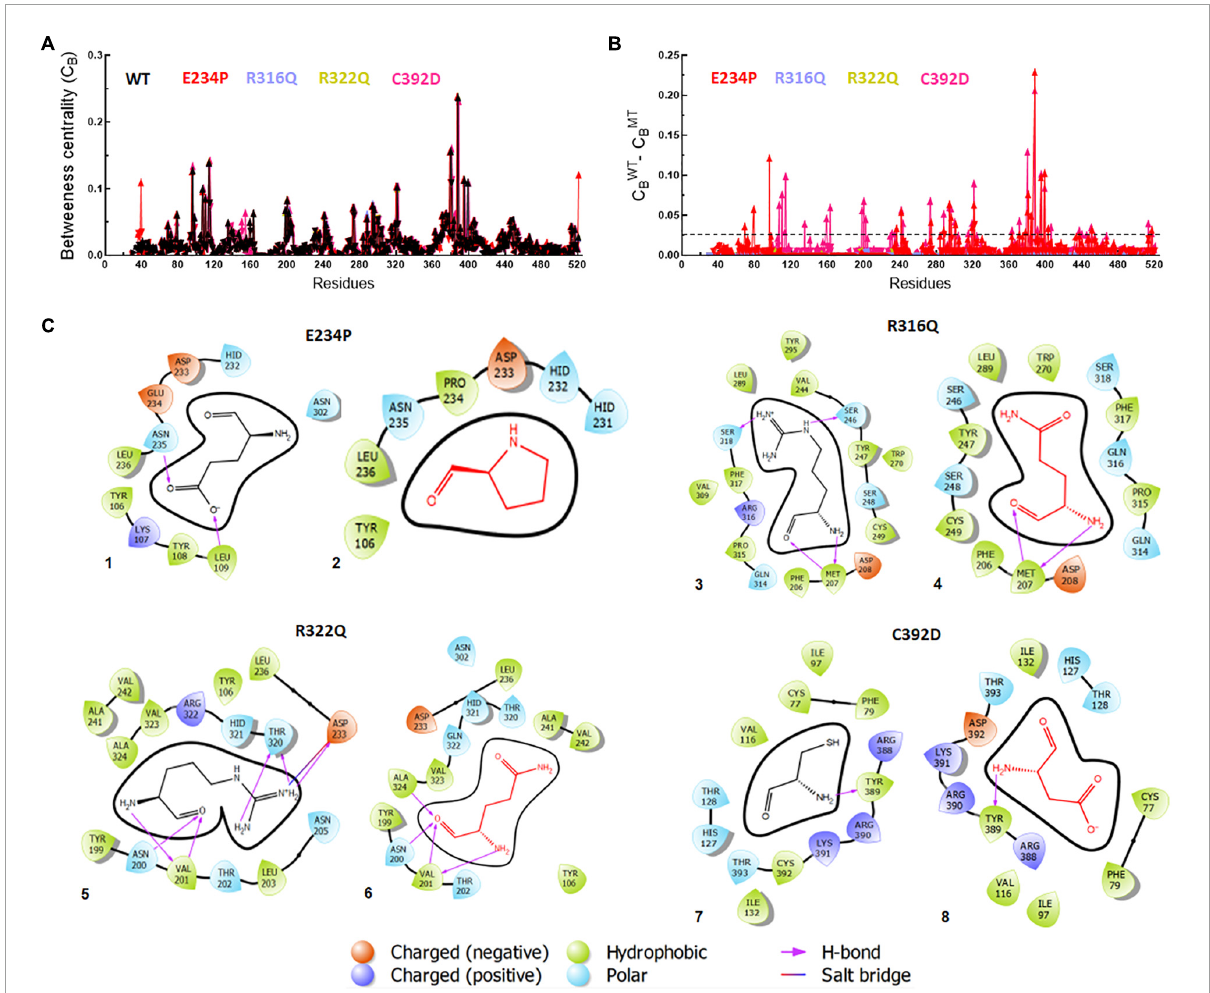
FIGURE7 Betweenness centrality (C B ) and residues interactions analyses of WT and MT proteins. (A) Individual betweenness centralities of MTs along with WT, (B) difference in betweenness centralities of WT and MTs and (C) 2D interaction maps of native and mutant residues. E234P (1 and 2), R316Q (3 and 4), R322Q (5 and 6) and C392D (7 and 8). Straight dotted line in panel (B) indicated cut-off C B value which should be less than 0.02. Native and mutant residues were labeled in black and red, color, respectively, while different charge residues and bonding were depicted in different color as shown above in the